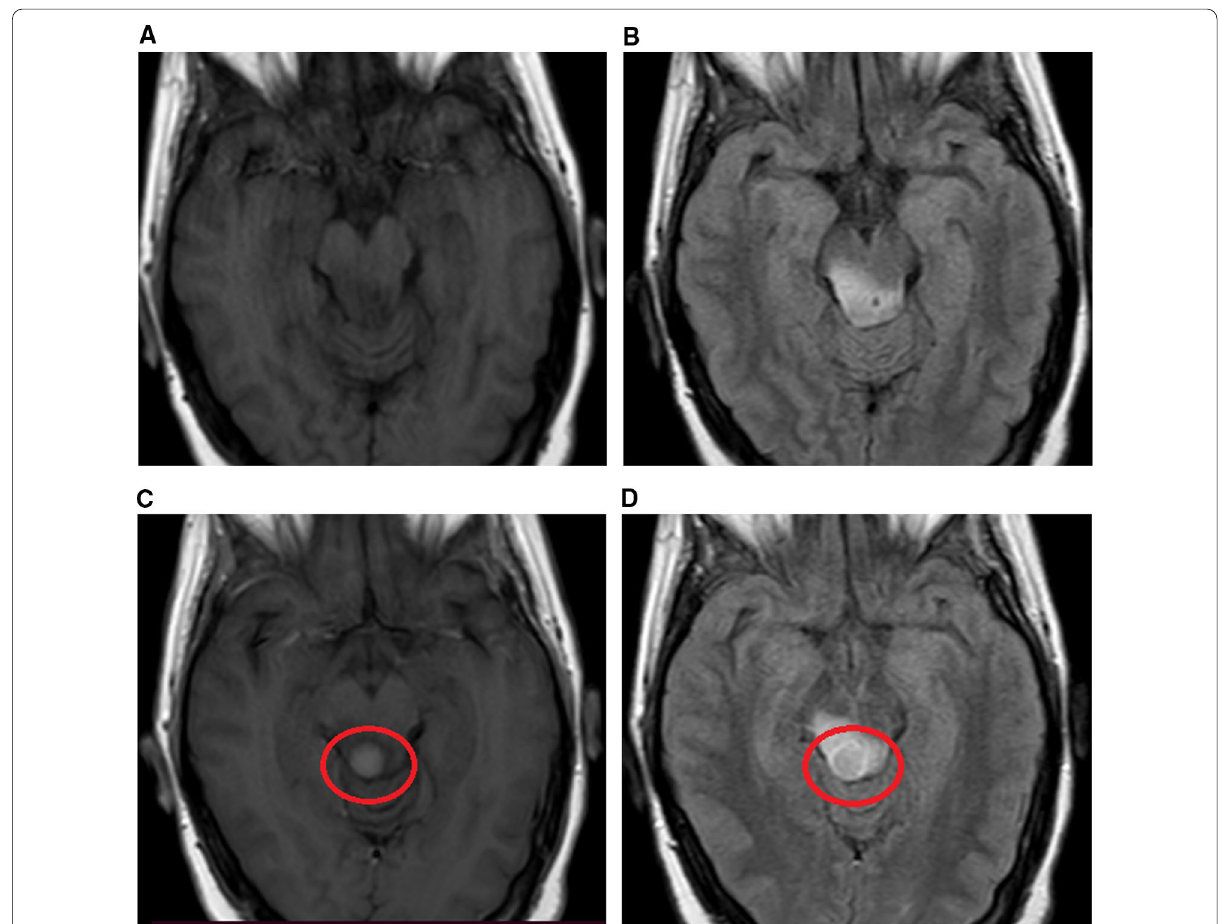
Fig. 6 A 51-year-old female patient with breast cancer. MRI of the brain shows an intra-axial focal lesion, epicentered upon the right side of tectum of the midbrain, with homogeneous intralesional post-contrast enhancement on CE-T1WI (C red circle). DPC-FLAIR demonstrates less intense lesion enhancement (D red circle). A Axial pre-contrast T1WI. B Axial FLAIR. C Axial CE-T1WI. D Axial DPC-FLAIR